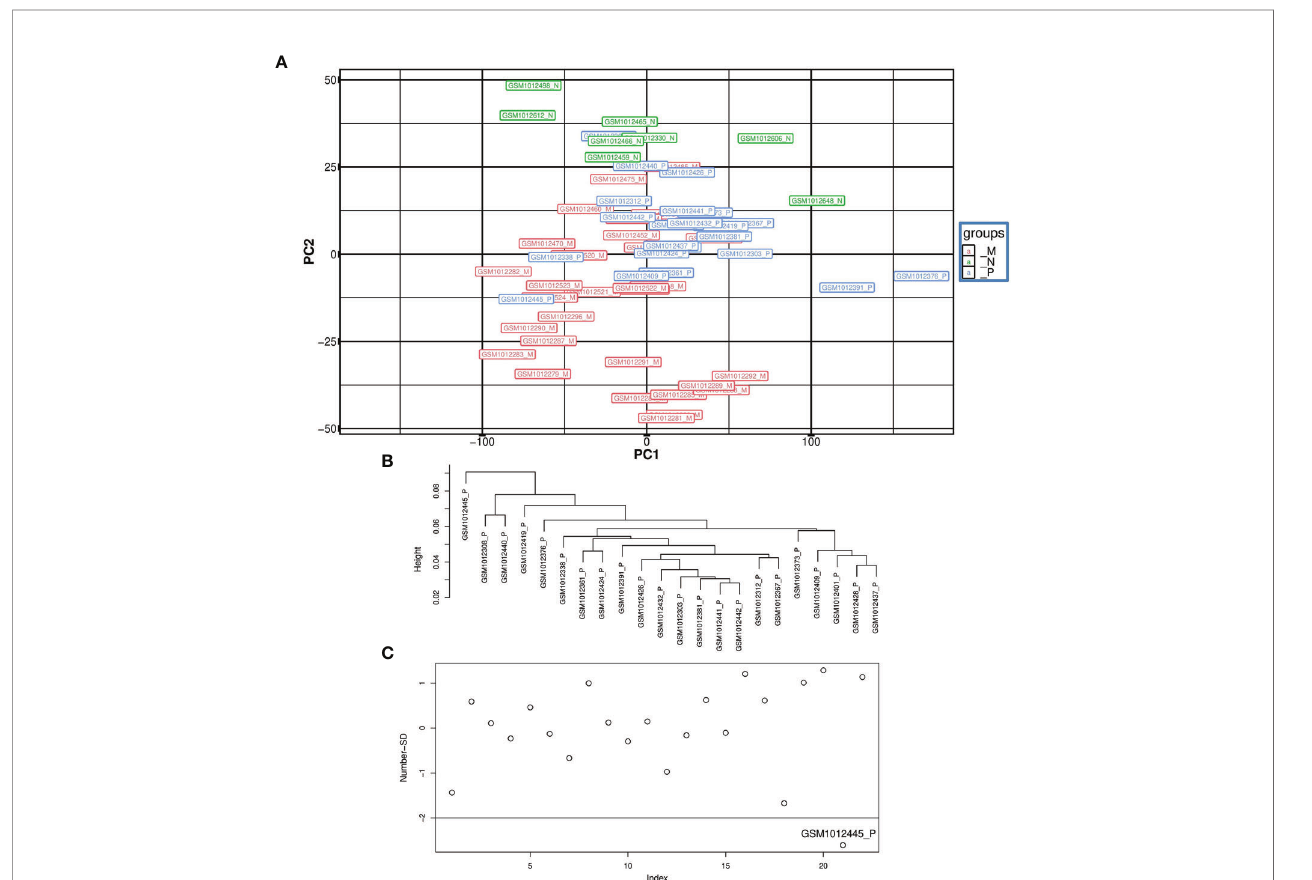
FIGURE 2 | Illustration of outlier samples in the fi rst dataset. (A) is the PCA plot, (B) is the dendrogram for the primary samples and (C) is the Number-SD plot for primary samples. GSM1012445 is an outlier sample in primary group as it has located in a distance from its group in the PCA plane. In addition, it has formed a unique cluster in the dendrogram and its Number-SD score is less than negative